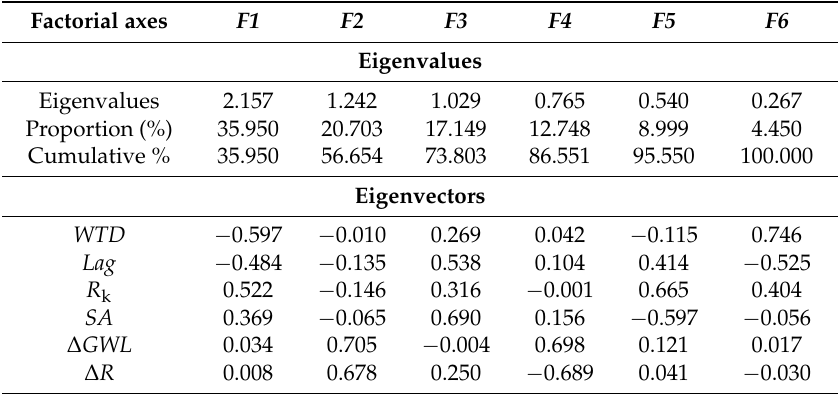
Table 7. Principal components from spatio-temporal PCA